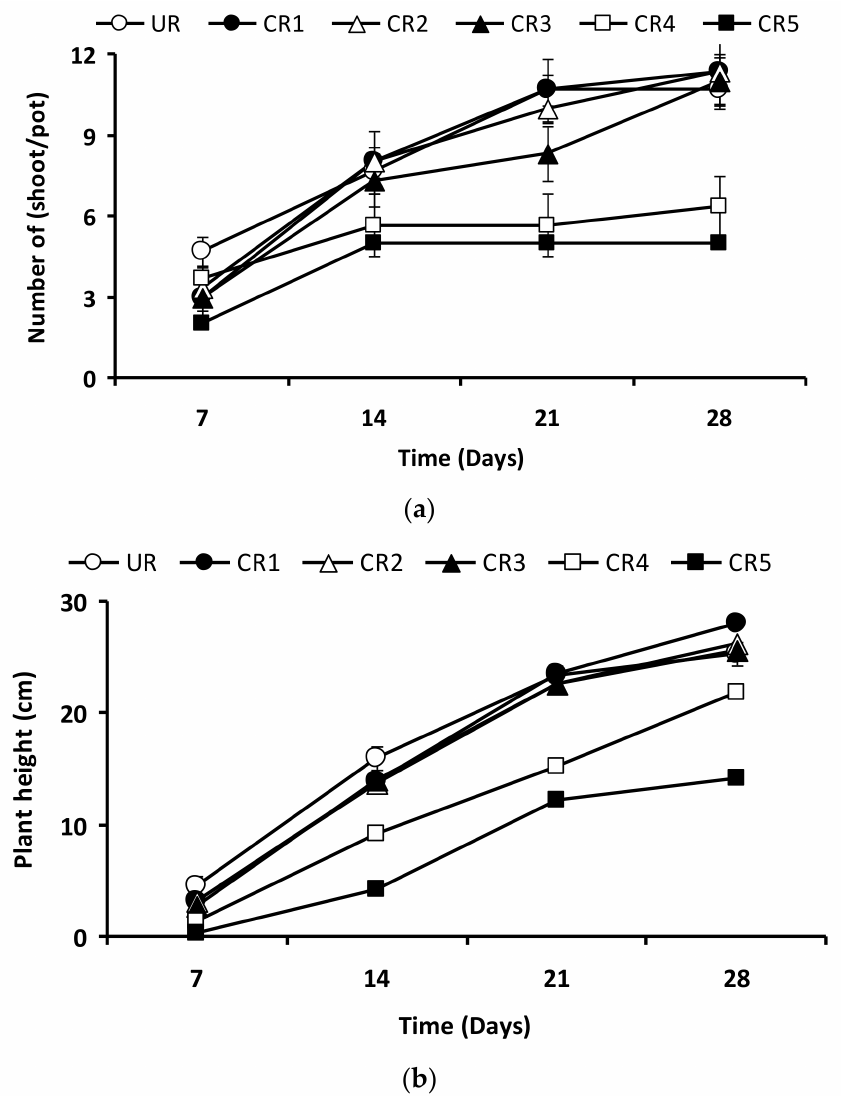
Figure 2. C. cajan number of shoots ( a ) and height ( b ) grown in POS-spiked soil. Bars represent means ± standard deviation ( n = 3). UR is an uncontaminated rhizosphere and CR 1 to CR5 represent contaminated rhizosphere with POS from 1 to 5% w / w